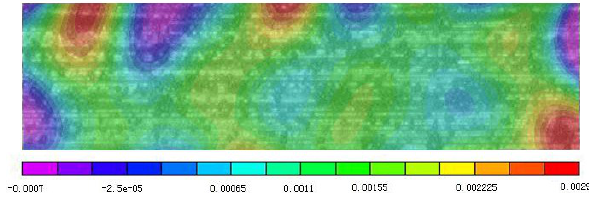
Figure 20: Strain distribution(Force=10N)